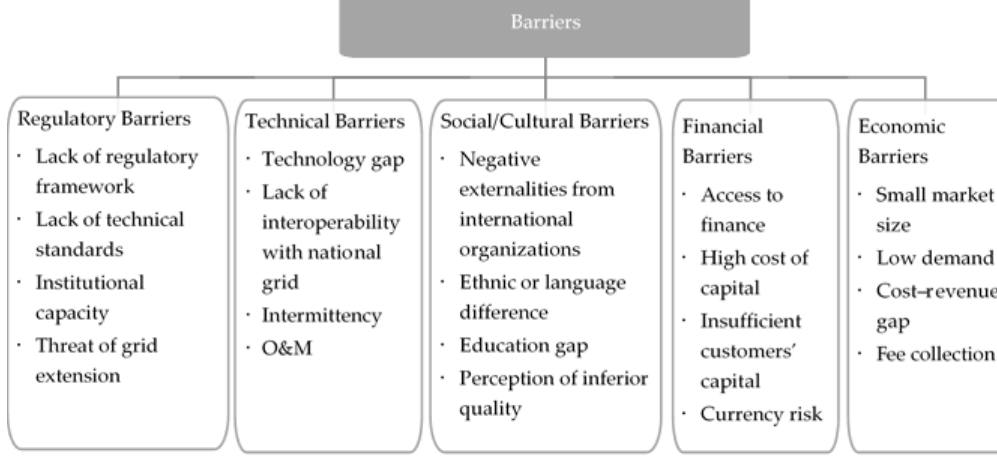
Figure 2. Weights of factors of economic, technical and regulatory barriers. 4.2. Barriers with Low Consensuses